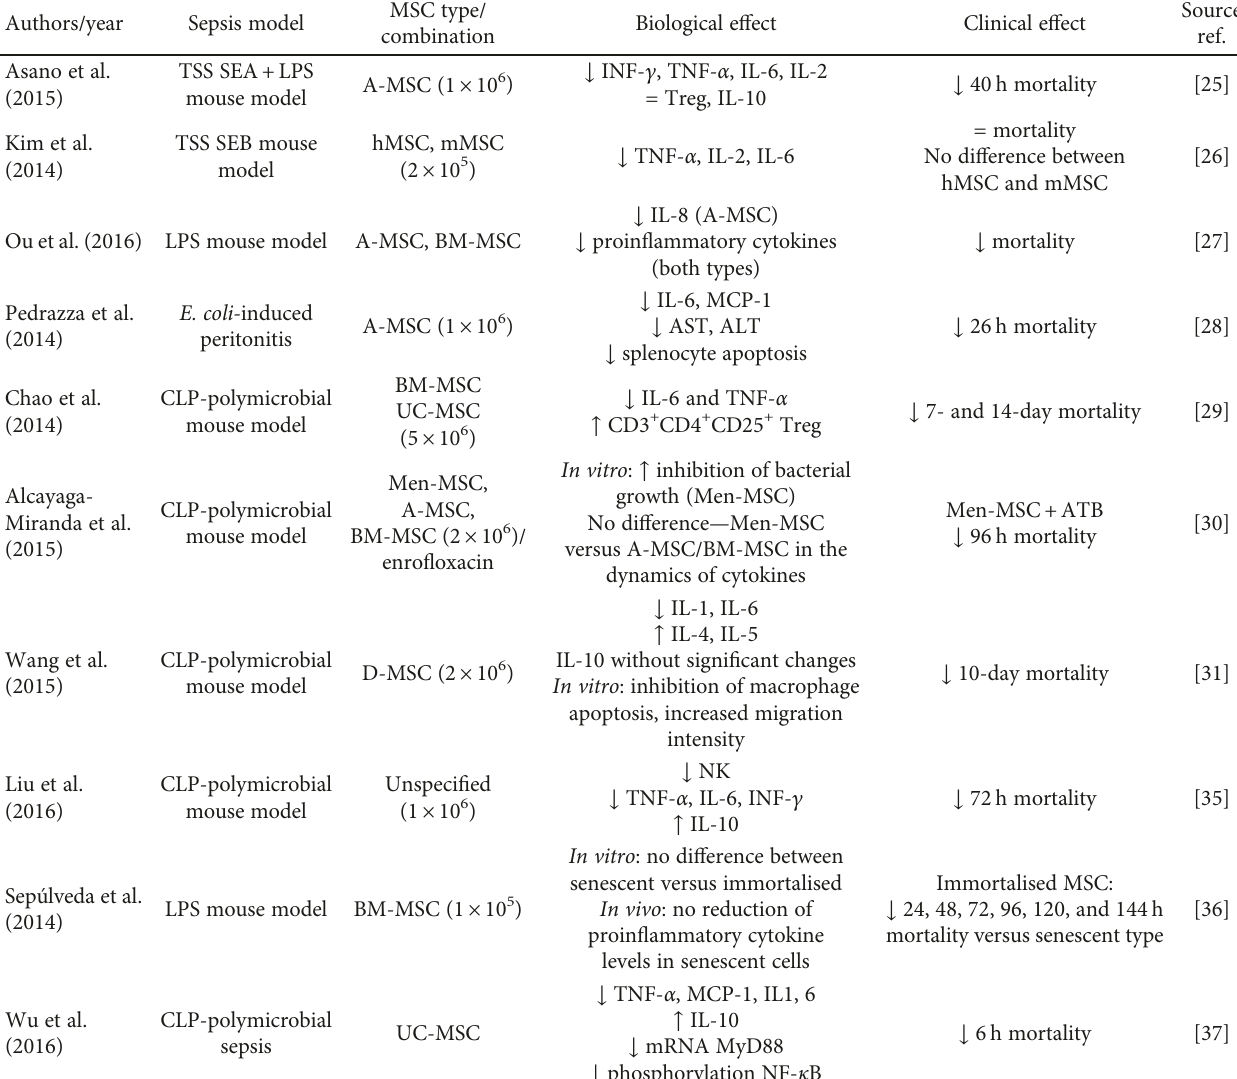
Table 1: Preclinical models of sepsis and role of